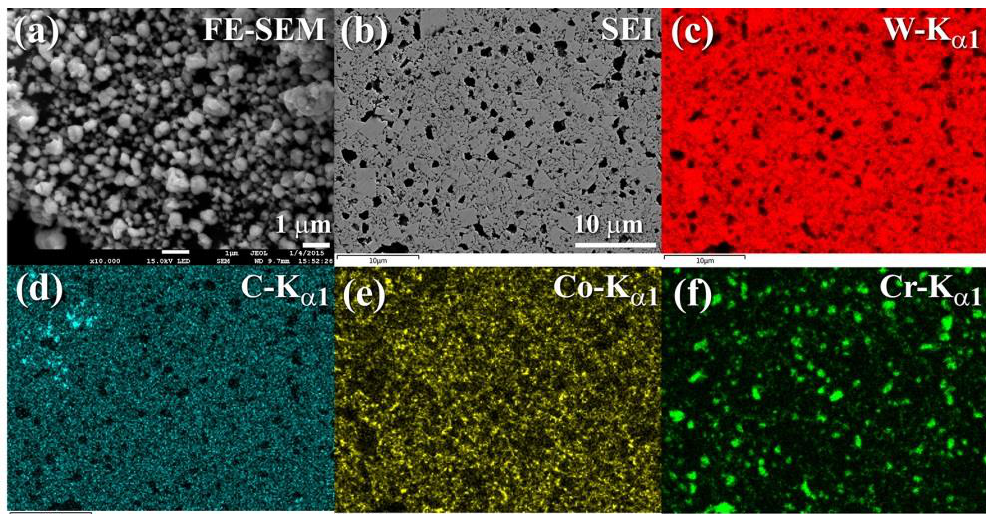
Figure 24. ( a ) FESEM of nanocomposite 93-WC/7 (10Co/4Cr) powders obtained after 50 of ball milling time. The cross- sectional view of the consolidated powders achieved at 1250 °C, using SPS technique is presented in ( b ) together with the corresponding X-ray elemental mapping of ( c ) W-Kα 1 , ( d ) C-Kα 1 , ( e ) Co-Kα 1 , and ( f ) Cr-Kα 1 .